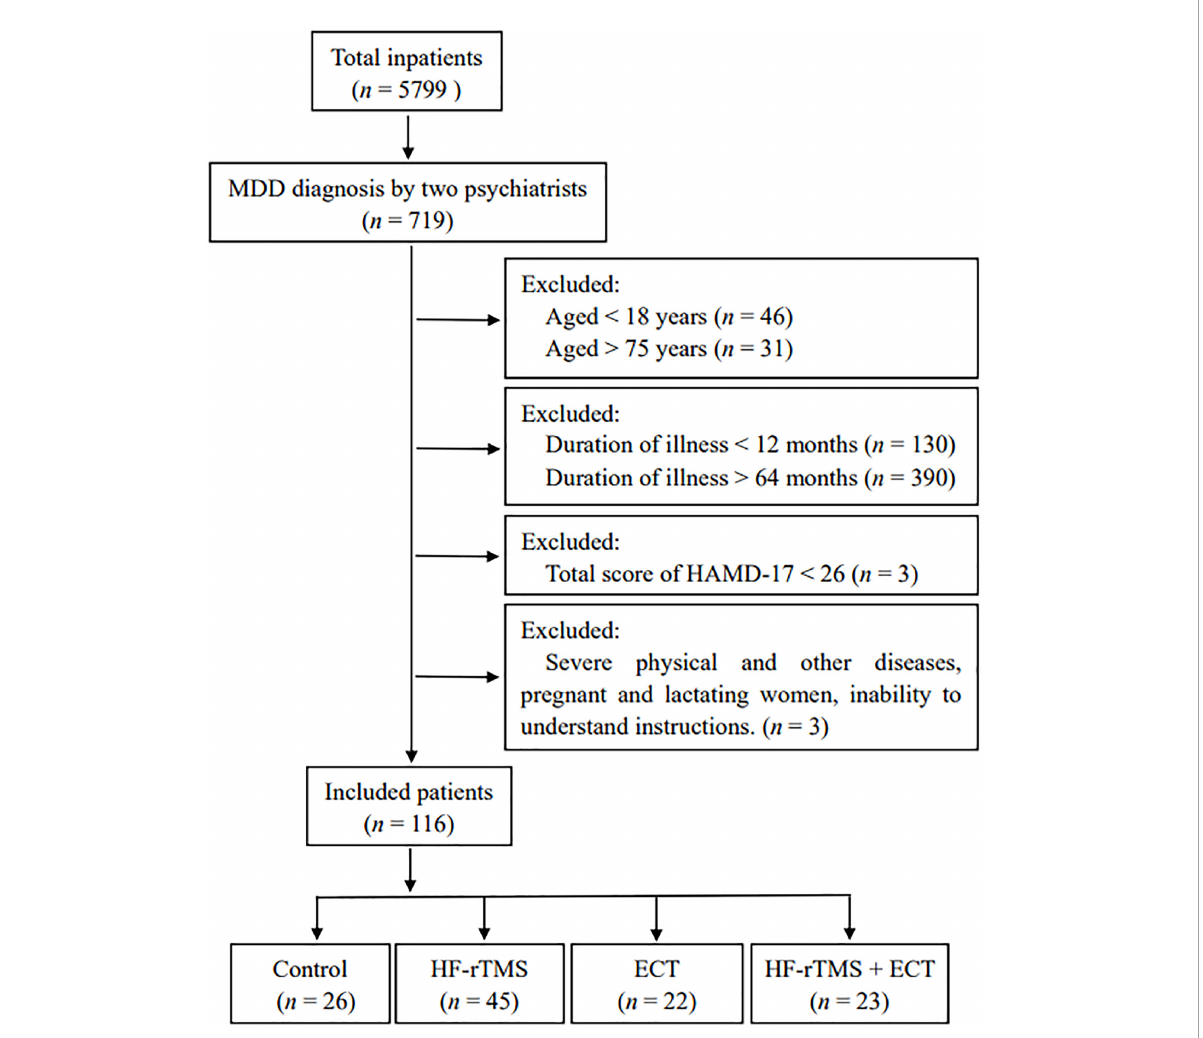
FIGURE1 Schematic of the participant flow. MDD, major depressive disorder; HF-rTMS, high-frequency repetitive transcranial magnetic stimulation; ECT, electroconvulsive therapy; HAMD-17, 17-item Hamilton depression rating scale.